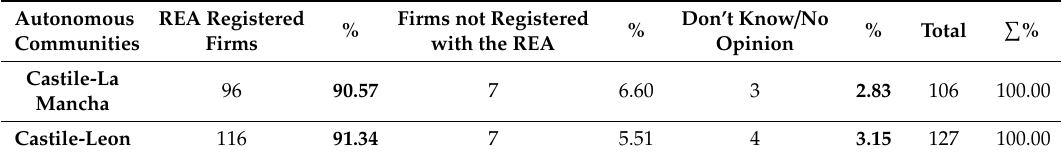
Table 6. Registration with the REA by Private Firms from the sector under study until 13 / 02 / 2017. Where: 100% = 106 Firms from Castile-La Mancha, and 100% = 127 Firms from Castile-Leon; the sample under analysis amounts to 233 Firms from the construction sector active in the national territory. Source : Ministerio de Trabajo, Migraciones y Seguridad Social